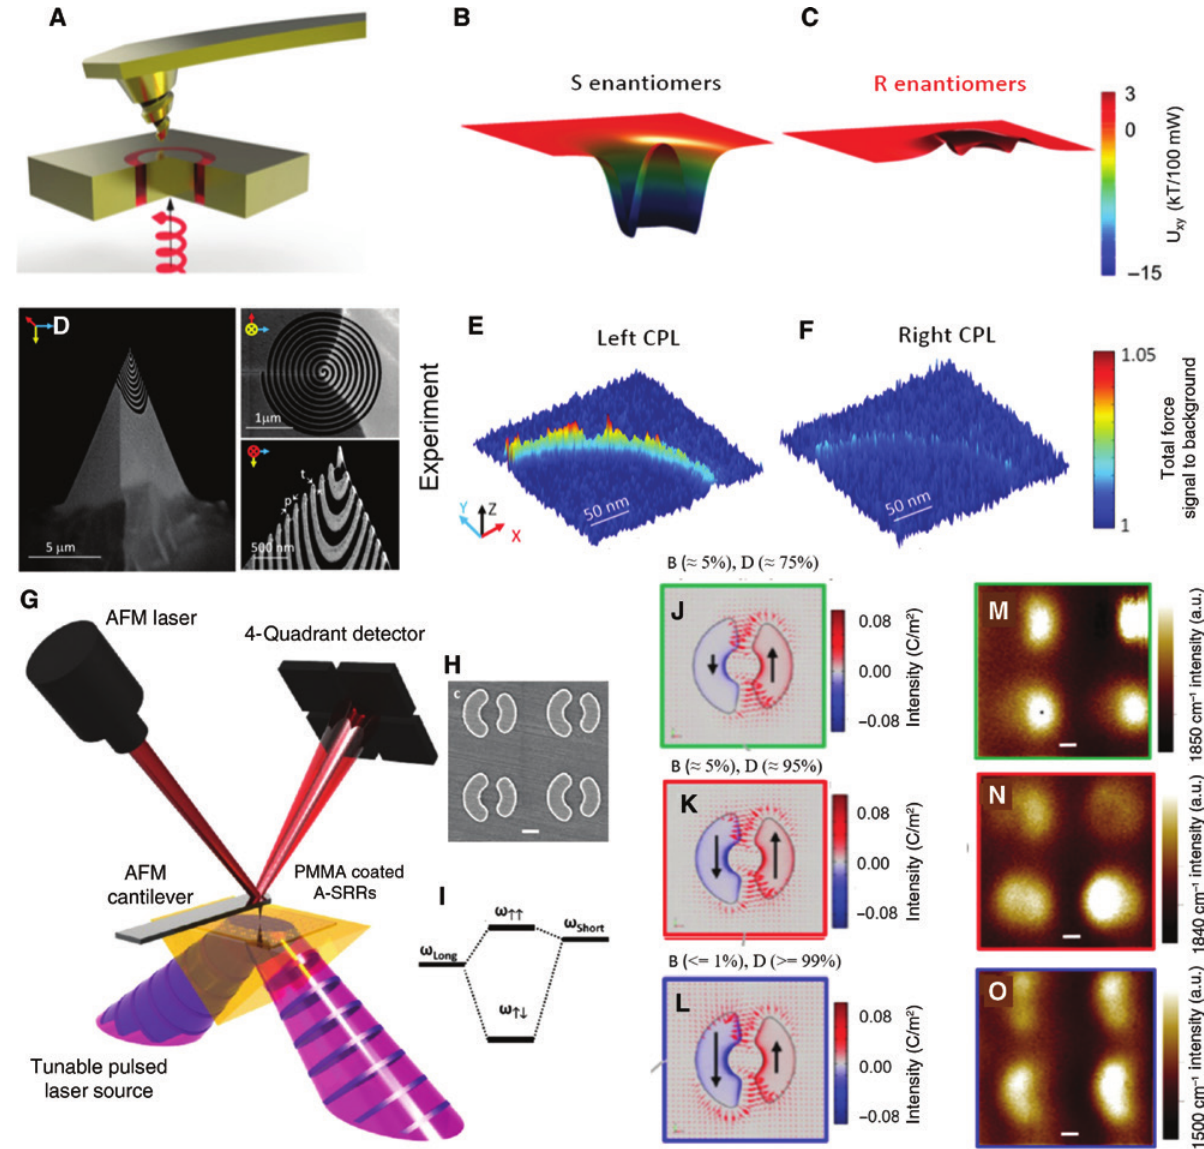
Figure 9: Enantioselective optical force microscopy [57, 65, 66]. (A) Schematic illustration of circularly polarized light (CPL) illuminate on coaxial plasmonic nano-aperture. (B, C) Simulated 2D trapping potential for enantiomers using the coaxial plasmonic aperture. The chirality of the enantiomer is assumed to be κ = ± 0.6, and the incidence is left-CPL. (D) SEM image of the chiral AFM tip (with left handedness). (E, F) Optical force map on the coaxial nano-aperture with left- and right-handed CPL incidence. (G) Schematic illustration of the PTIR measurement. Asymmetric split ring resonators (A-SSRs) are coated with PMMA. When IR laser pulses are absorbed by the sample (PMMA coated A-SRRs), the sample rapidly expands and deflects the AFM cantilever; the amplitude of the deflection is proportional to the absorbed energy. (H) SEM of the A-SRRs. (I) Frequency splitting due to coupling between the long and short SRRs. (J–L) Electric field distribution of different mixture of bright-mode and dark-mode with various ratio. (M–O) PTIR at the wavenumber of 1850 (mixture of dark- and bright-mode), 1500 (dark-mode), and 1191 cm −1 (mixture of dark- and bright-mode. PMMA CH wagging mode) (Figures adapted from Refs. [57, 65, 3